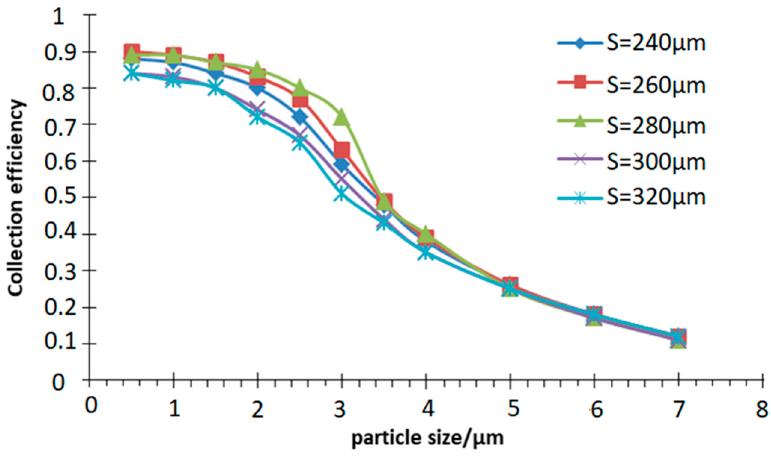
Micromachines 2019 , 10 , x Figure 4. Collection e ffi ciency curve with di ff erent second channel width ( S ). Figure 4. Collection efficiency curve with different second channel width ( S ).